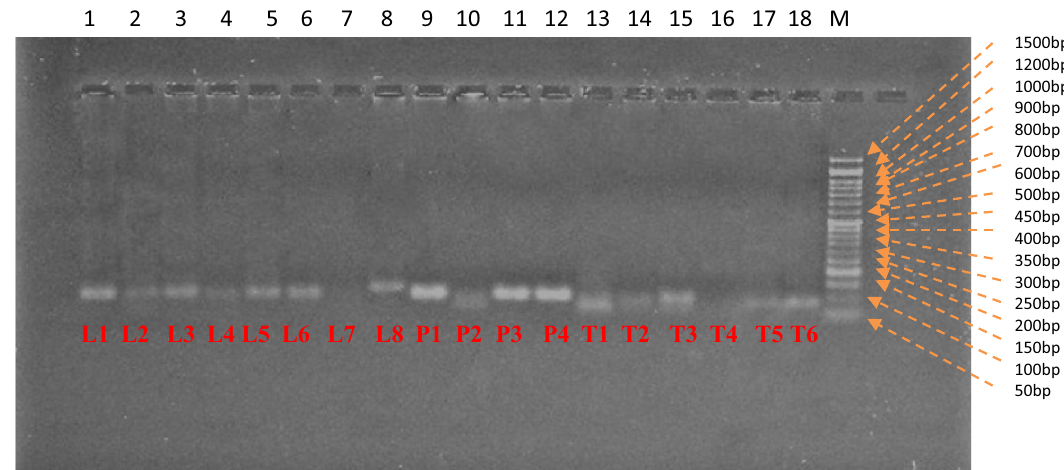
Figure 3. PCR amplicons of partial pqqC gene fragment. Lanes: 1. L1; 2. L2; 3. L3; 4. L4; 5. L5; 6. L6; 7. L7; 8. L8; 9. P1;10.P2;11.P3;12.P4;13.T1;14.T2;15.T3;16.T4;17.T5;18.T6 Lanes: M denotes 50 bp DNA ladder.